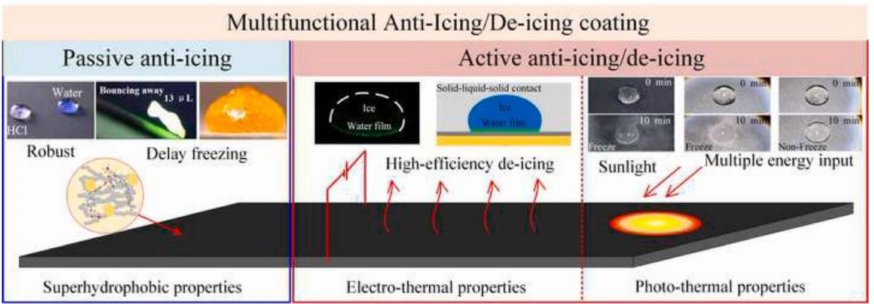
Figure 4. Combination of superhydrophobic coatings with electrothermal and photothermal proper- ties (reproduced from Zhao et al. [74] with permissions from